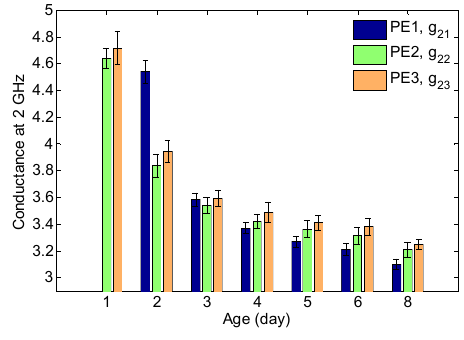
Figure 5. Measured temporal response of electrical conductance at 2 GHz.